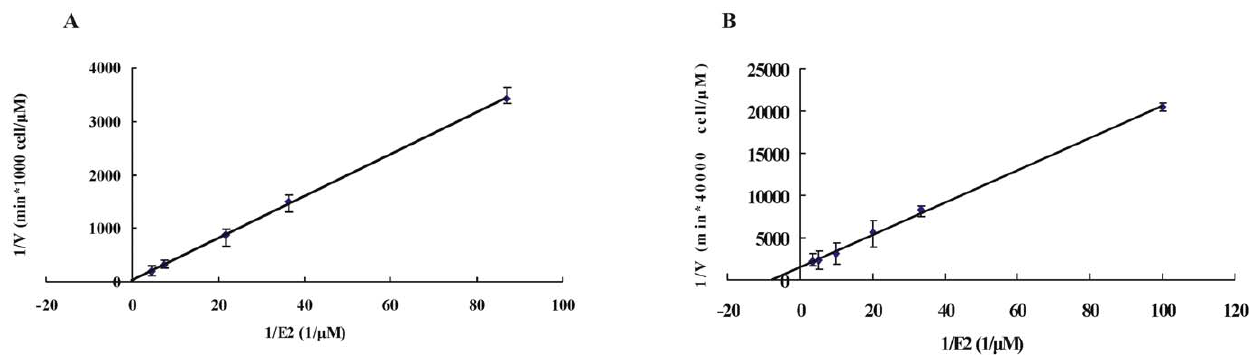
Figure 6. Double-reciprocal plot of 17 b -HSD1 catalyzing estrone reduction in HEK-293-17 b -HSD1 (A) and T47D (B). 1,000 HEK-293- 17 b -HSD1 cells and 40,000 T47D cells were seeded onto 24-well plates. E1 concentrations varied from 0.01 m M to 0.3 m M. Initial velocities were measured with less than 10% substrate consumption. The final concentration of ethanol was standardized to 0.05% in all reactions.